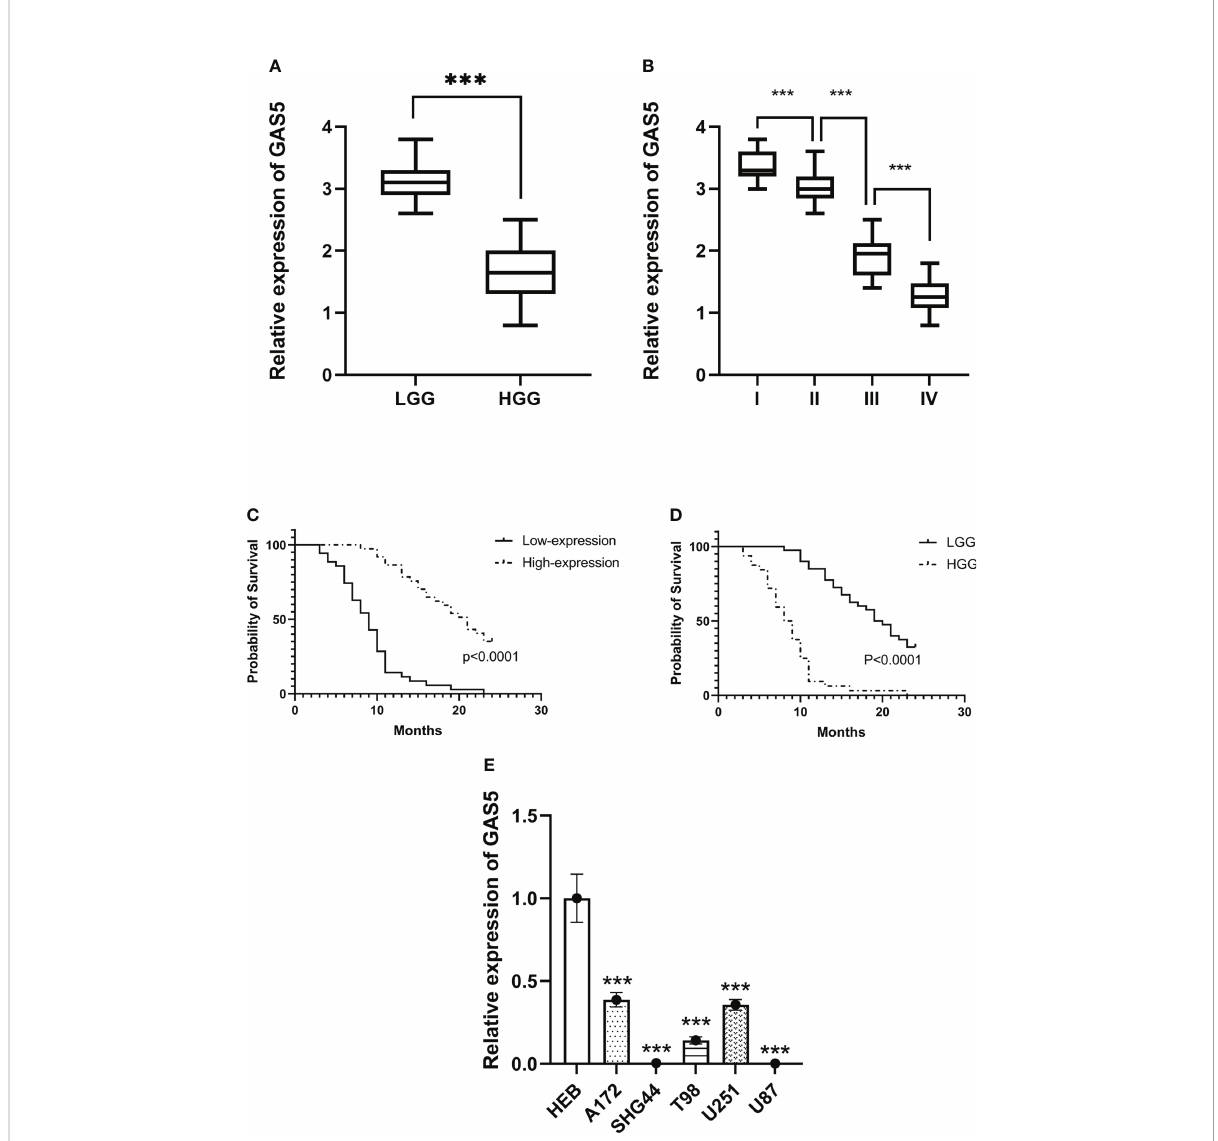
FIGURE 1 LncRNA-GAS5 is low-expressed in high-grade glioma tissues and cells. (A) GAS5 levels are measured in high grade glioma (HGG) tissues (n=36) and low-grade glioma (LGG) tissues (n=36) by qRT-PCR using GAPDH as a reference gene. (B) GAS5 levels are measured in WHO I (n=11), II (n=29), III (n=18) and IV (n=14) grade glioma tissues using GAPDH as a reference gene. (C) Kaplan-Meier survival curve of patients divided into HGG (n=36) and LGG (n=36) involved in our study is shown. (D) Kaplan-Meier survival curve of patients is divided into high-expression group and low-expression group according to the expression of GAS5 involved in our study is shown. (E) RNA is extracted from glial cell line (HEB) and fi ve types of glioma cell lines (A172, SHG-44, T98, U251, U87) (n=3 in each cell lines), GAS5 expression level is measured by qRT-PCR using GAPDH as a reference gene. Unless otherwise noted, data are presented as the mean ± S.D. P value is determined by Student ’ s t-test (***P <